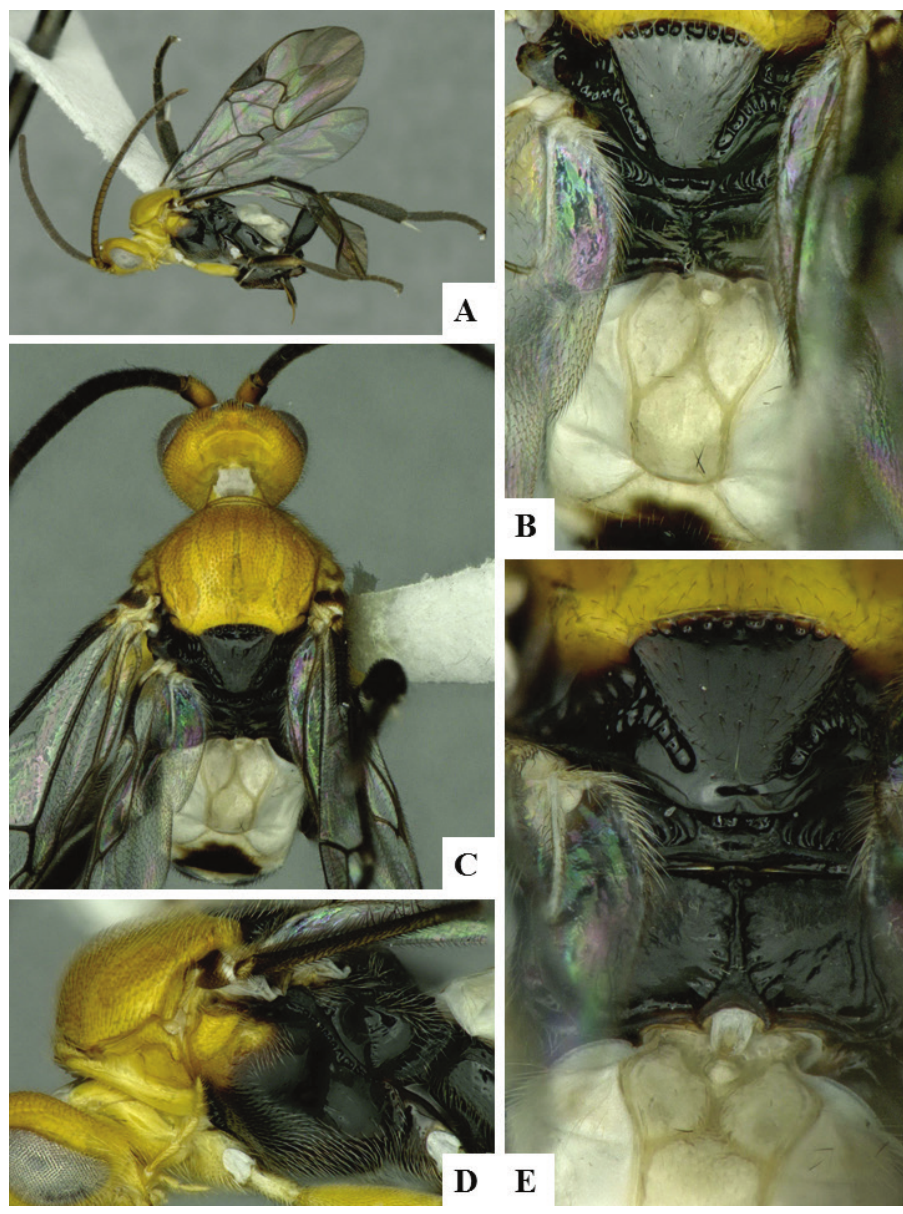
Figure 44. Ypsilonigaster tiger female holotype. A Habitus B Tergite 1 C Mesosoma dorsal D Mesosoma lateral E